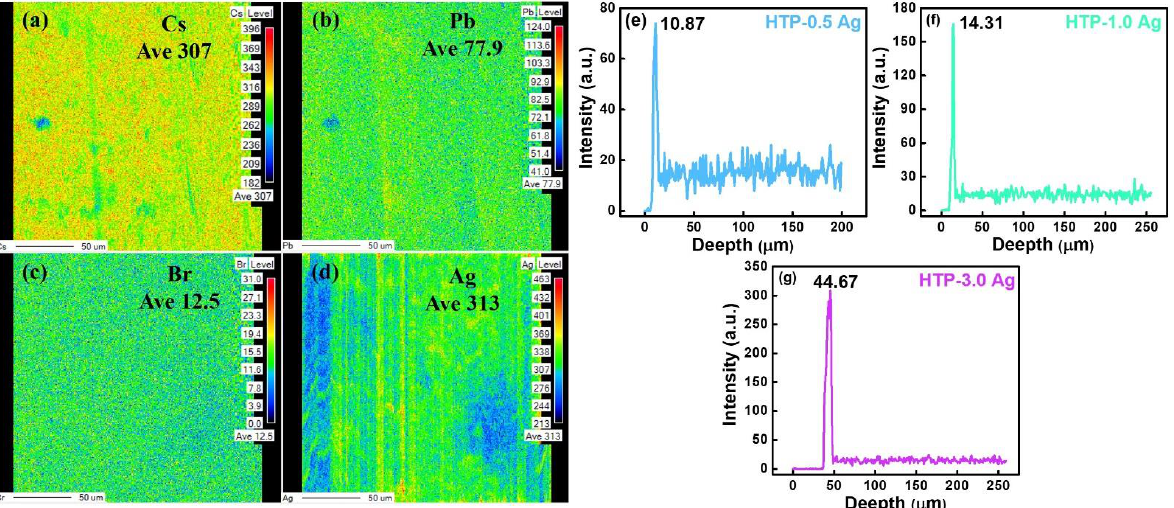
Figure 6. ( a – d ) the elemental maps of Cs, Pb, Br and Ag of HTP-1.0 Ag and ( e – g ) the depths of Ag + ions in HTP-0.5 Ag, HTP-1.0 Ag and HTP-3.0 Ag glass samples.